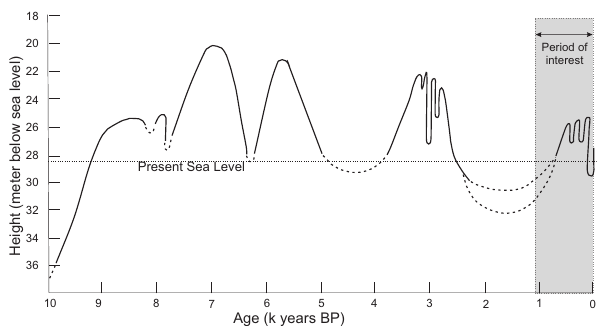
Fig. 2. Caspian sea-level changes during the last 10000yr, in un- calibrated radiocarbon ages (Rychagov, 1997). The study period of the present investigation is denoted by the grey